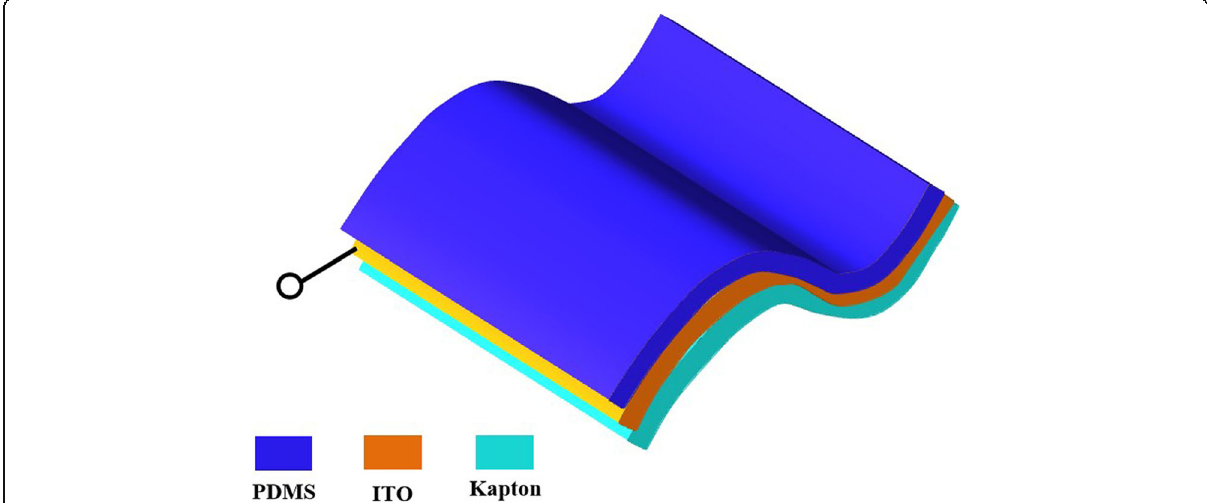
Fig. 2 Schematic of the double-sided polymer nanostructures